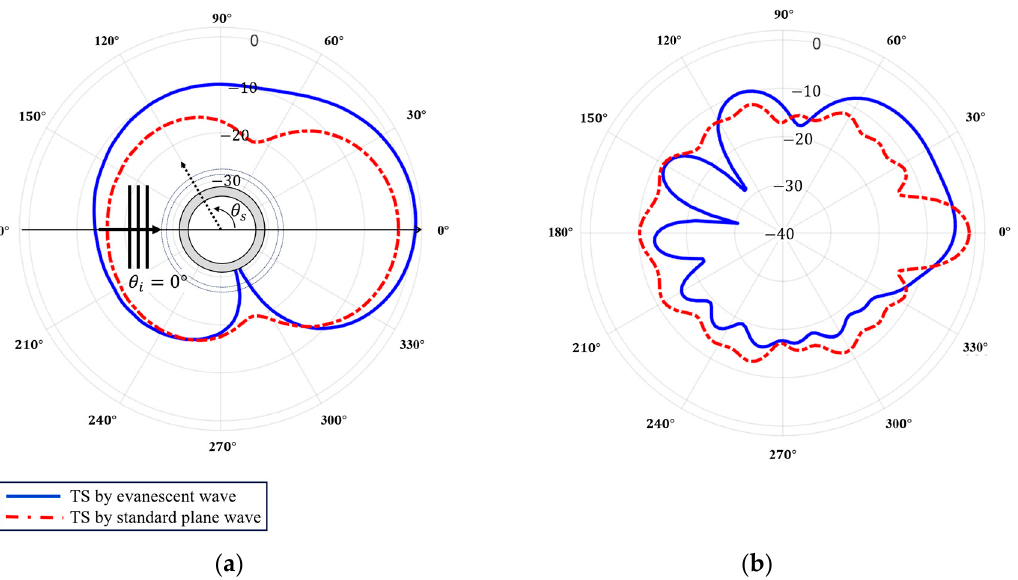
Figure 3. Target strengths (in the unit of dB) calculated at ( a ) 3 kHz and ( b ) 9 kHz using FEM when the incoming waves are the evanescent waves having the same decaying rates and propagation speeds as the penetrating waves at subcritical angles; they are compared with those for standard plane waves at corresponding frequencies. In the TS calculation, the free-field target is surrounded by the sediment.